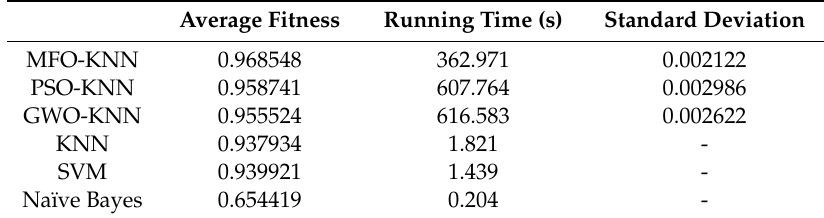
Table 3. Experimental results of 8000 data sets. Table 2. Experimental results of 4000 data sets.